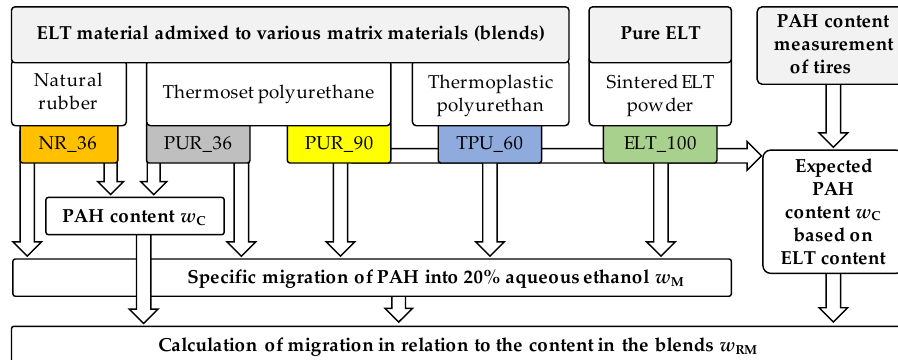
Figure 5. Experimental setup (PAH content measurement of tires [6]).